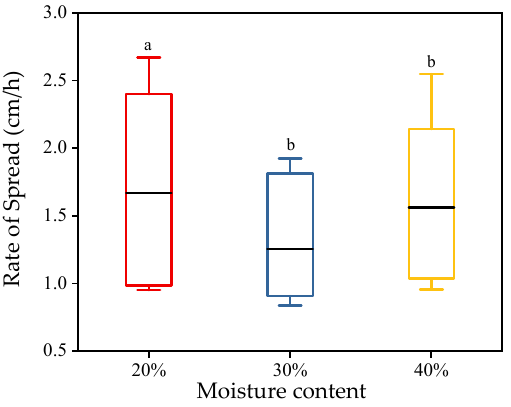
Figure 8. Variance analysis on influence of moisture content on rate of spread of smoldering during sub-surface fires (a,b means that if there is any same lowercase letter, the difference is not significant).